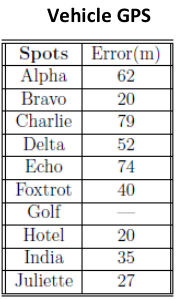
Table 10: Estimated errors in hot spot